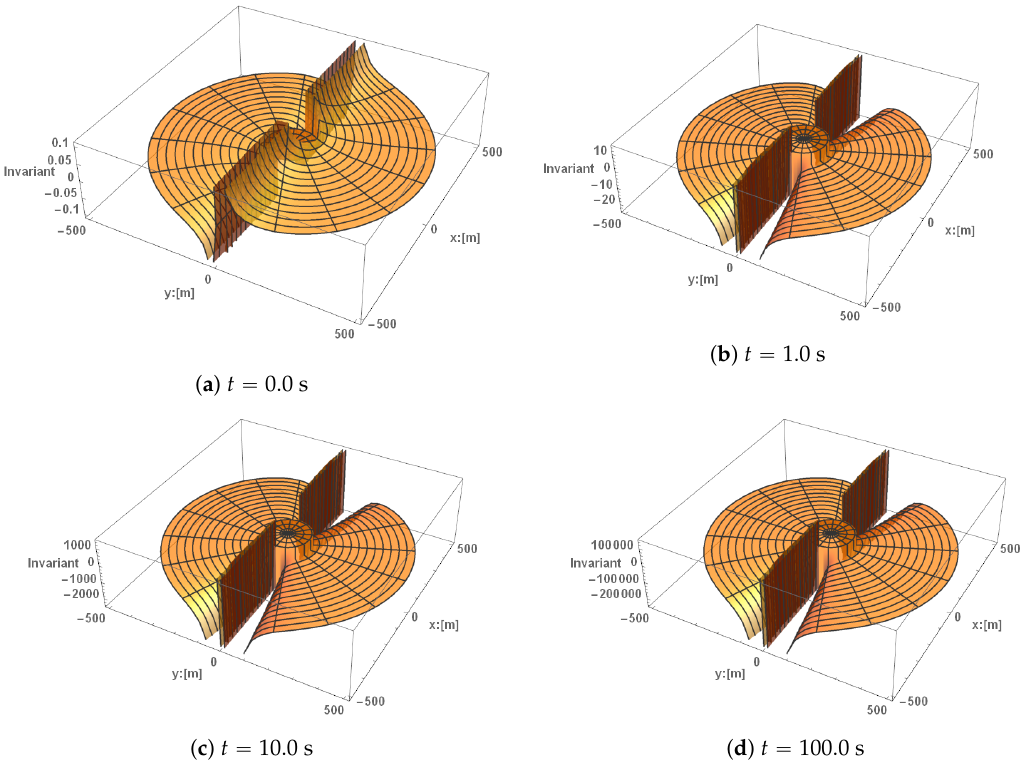
Figure 1. The time, t , of the Ricci Scalar R is plotted in the figures above. The other parameters were set to be σ “ 50,000 m ´ 1 , ρ “ 100 m, and a “ 1.0 m s ´ 2 . The plots were rendered using Mathematica’s ® RevolutionPlot3D. It plots a function by rotating the function around the z-axis. The amount that the space diverges from being flat is represented by the invariant function’s magnitude, and its amount is labeled on the vertical axis. The x and y-axis are displayed on the plots, and they display the distance from a spaceship in the flat portion at the center of each figure. Each radial line in the plot corresponds to a distance of approximately 33 m. The portion of small negative curvature to the right of the harbor is to the front of the warp bubble, and the portion to the left of the harbor is the back of the warp